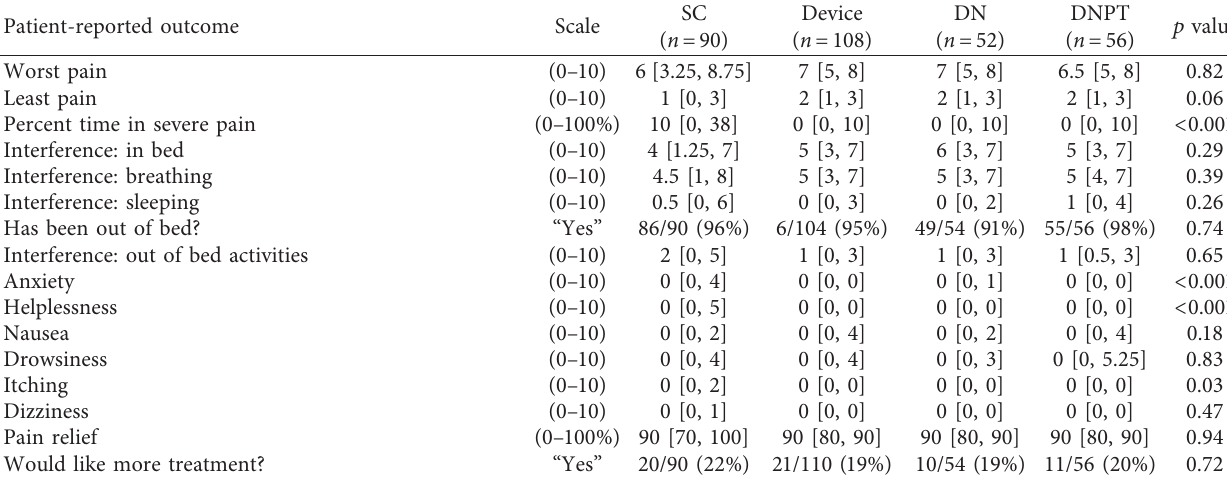
Table 6: International Pain Outcome Questionnaire